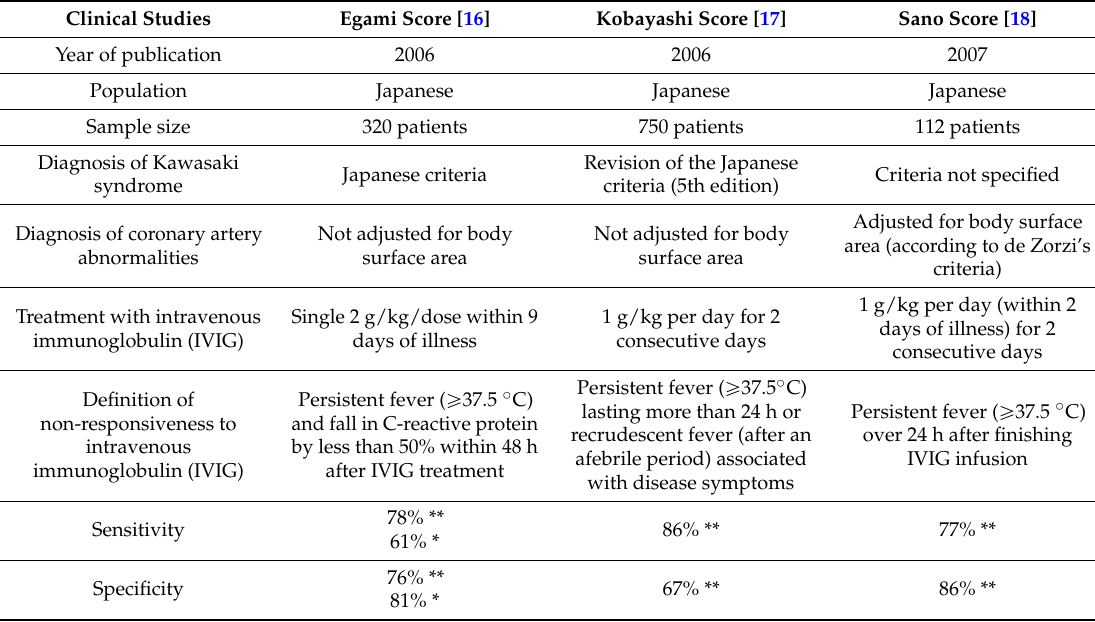
Table 3. Differences among the clinical studies for which the latest risk scores for Kawasaki syndrome were